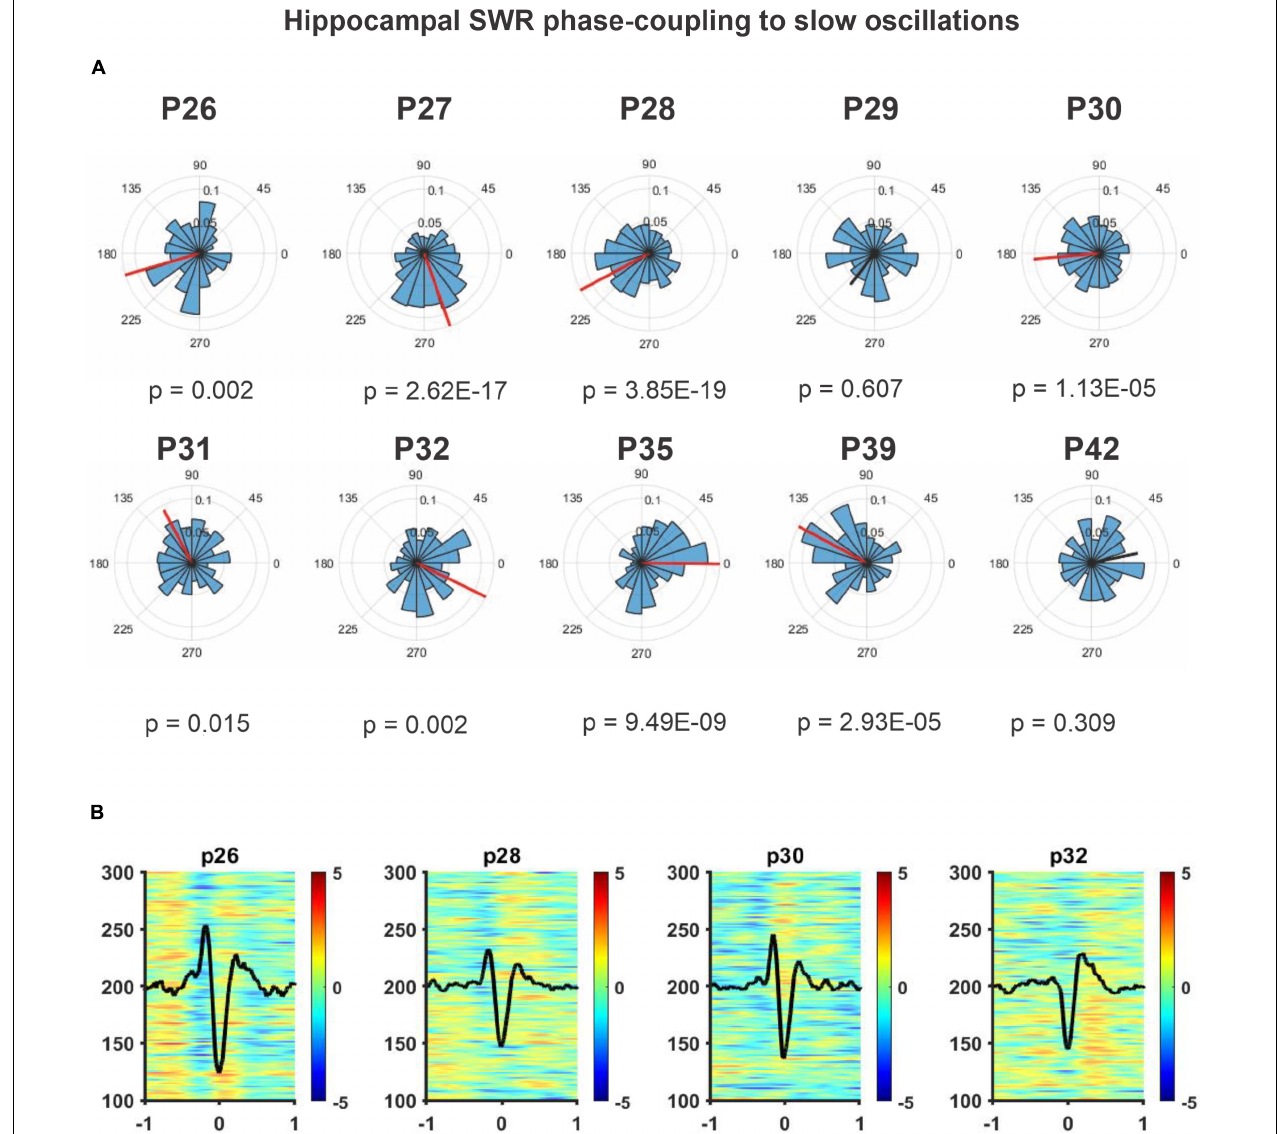
FIGURE 9 | Hippocampal SWR phase-coupling to slow oscillations. (A) Polar histograms across the postnatal day from P26 to P42 ( n = 4). The resulting vector represents the mean direction and length for each case. The threshold for significant directionality was set at p = 0.05 (Rayleigh’s test for non-uniformity), significant is shown in red, otherwise in black. The 90 ◦ corresponds to the peak of the SO event (up-state) and 270 ◦ to the SO-trough (down-state). Ripple events were coupled predominantly to the trough of the slow-wave ( p < 0.015) across the postnatal days. Except for P42. (B) SO-triggered SWR average spectrogram from cortical LFPs. SO down-state centered at 0 ± 1 s. No changes in power in the SWR frequency range (100–200 Hz) were detected. Statistical comparisons were performed through a non-parametric permutation test (MonteCarlo, n = 1000) using a cluster alpha of 0.02 and with a significance mask of p < 0.01.